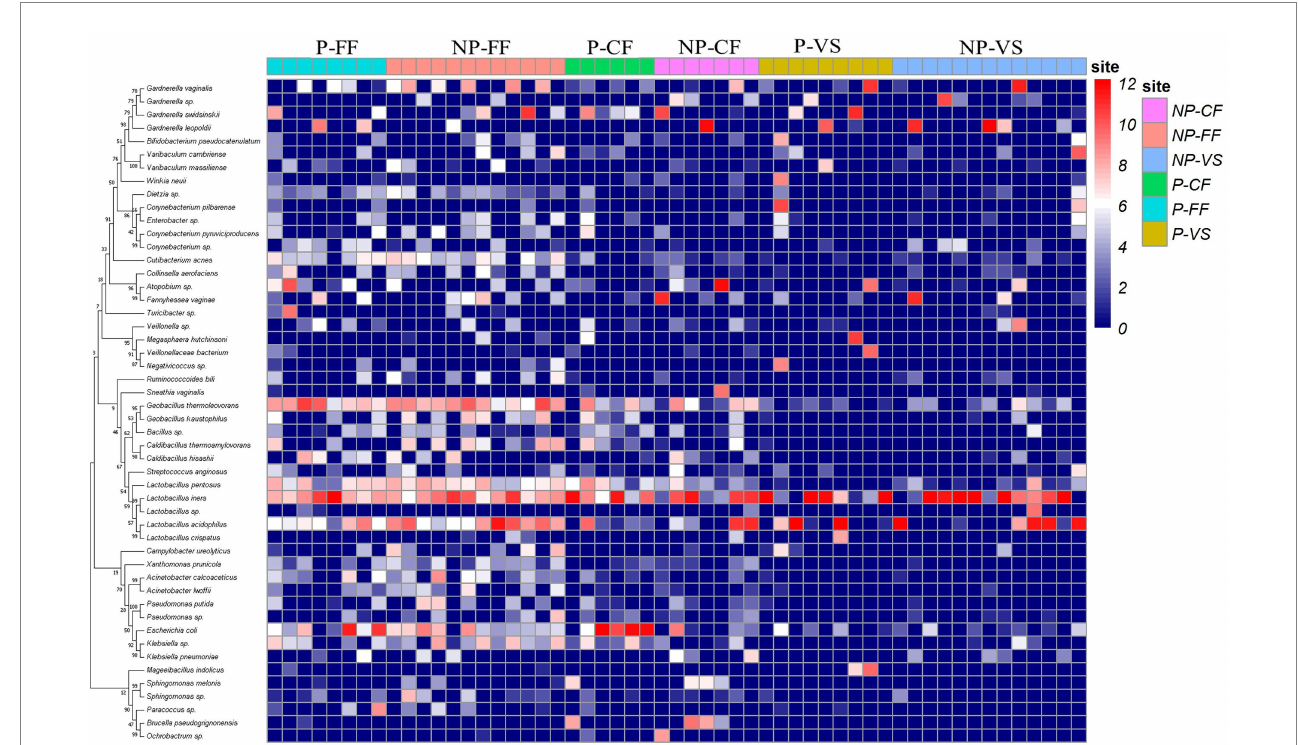
FIGURE 8 OTU heat map of the top 50 abundances in different samples. P-FF, Pregnancy follicular – Fluid; NP-FF, Non-pregnancy – Follicular fluid; P- CF , Pregnancy – Cervical fluid; NP- CF , Non-pregnancy – Cervical fluid; P- VS , Pregnancy – Vaginal swabs; NP- VS , Non-pregnancy – Vaginal